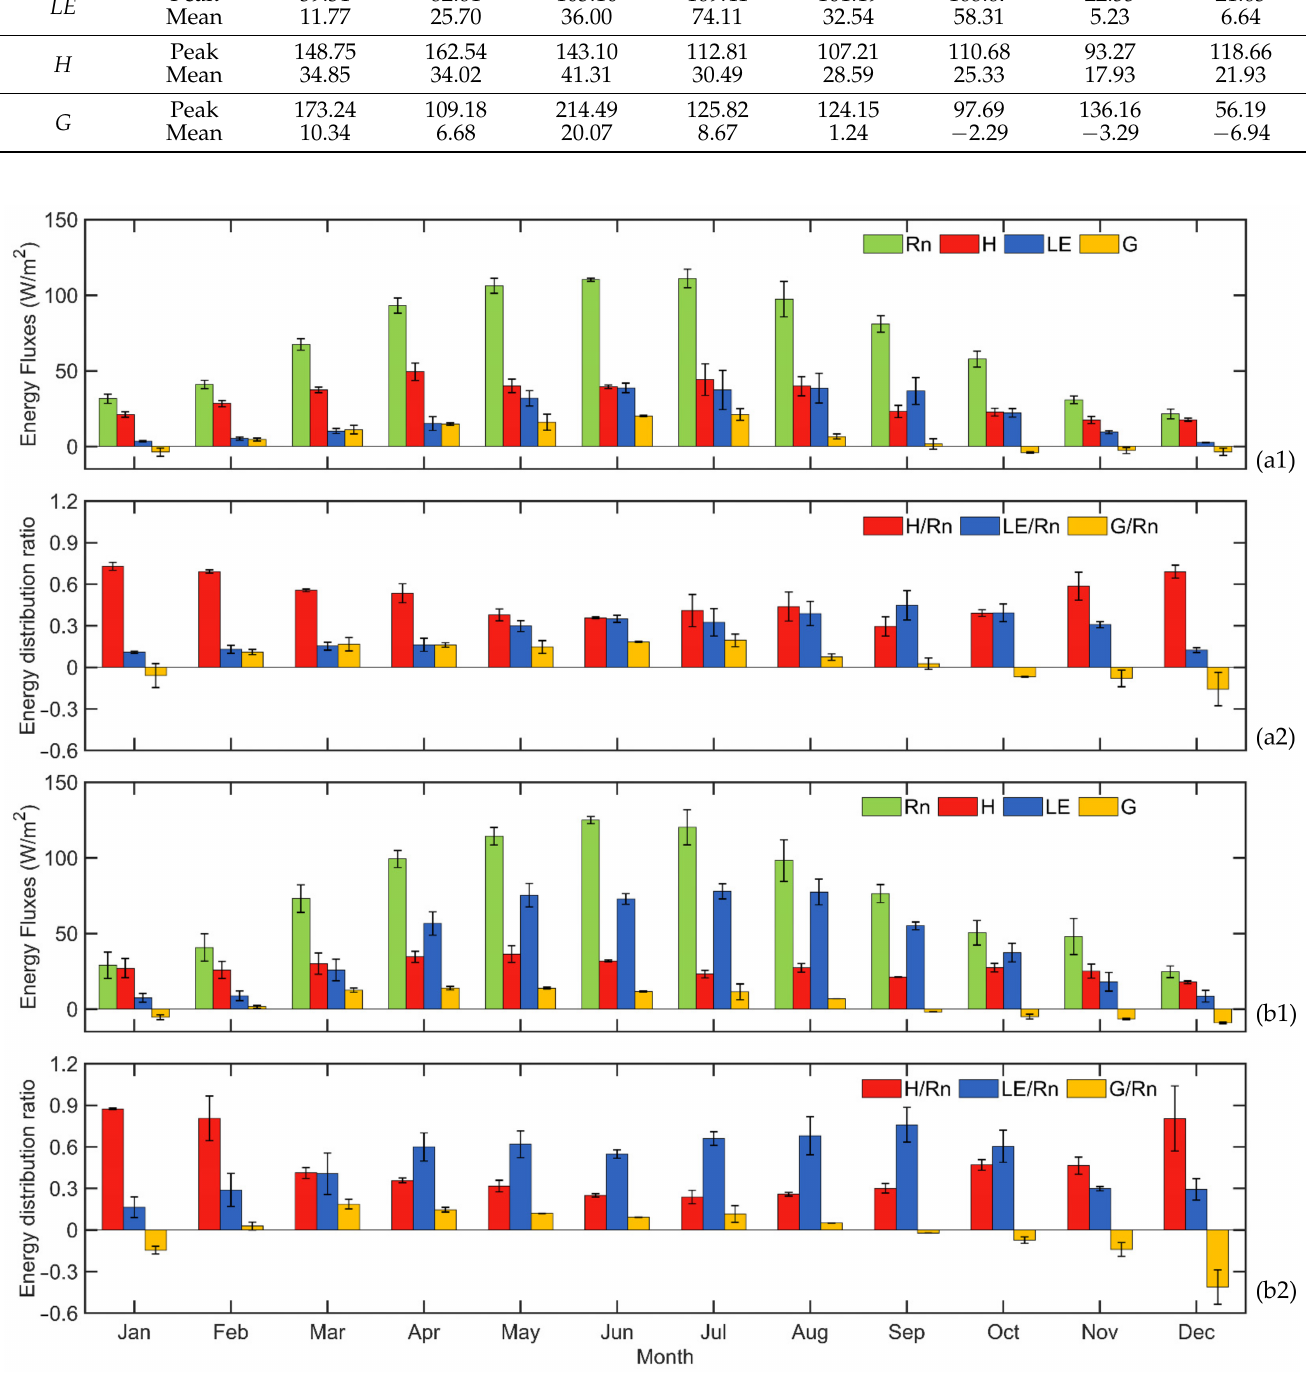
Figure 7. Seasonal variation in the energy components ( a1 , a2 ) and the ratio of H , LE , and G to Rn in Dingxi ( b1 ) and Qingyang ( b2